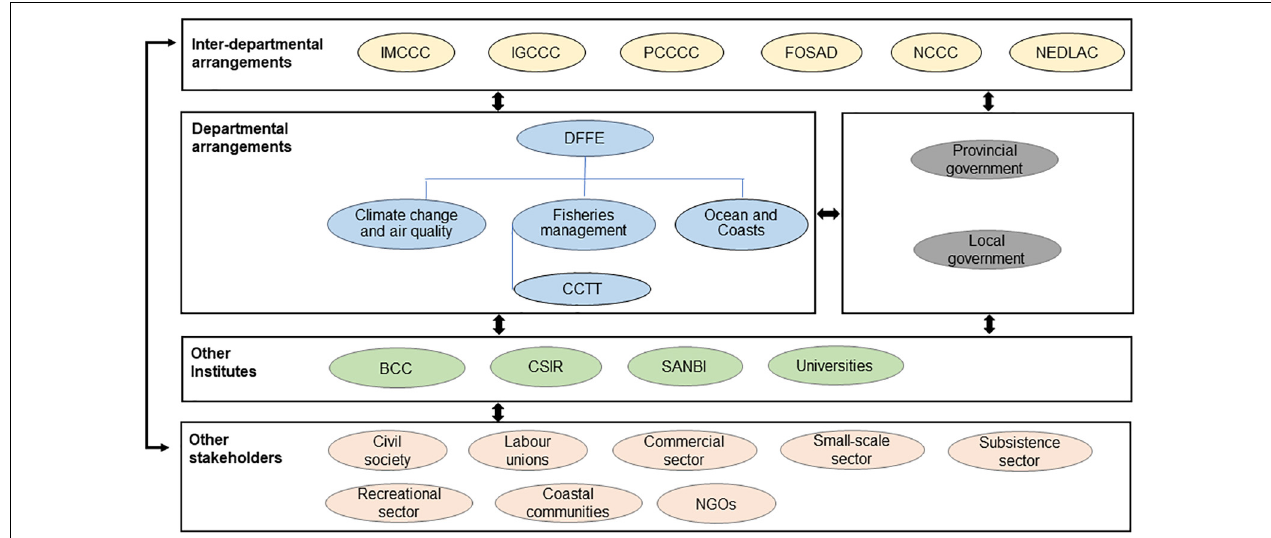
FIGURE 1 | Schematic representation of the institutional arrangements for climate change and fisheries in South Africa. The figure shows a clear delineation between stakeholders, however in reality, there is an overlap between different institutions, mandates and roles which the figure does not show. See section “Background” for